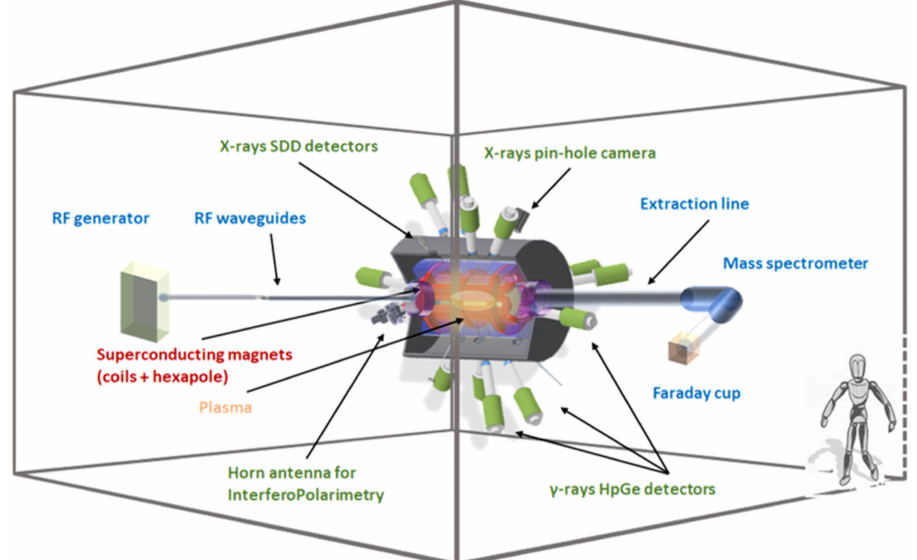
Figure 1. Rendering of the PANDORA setup, including the superconducting magnetic system (in red) inside its cryostat and iron yoke; the array of HPGe detectors; the main diagnostics (optical, X-ray, interfero-polarimetry); the mass spectrometer and the RF